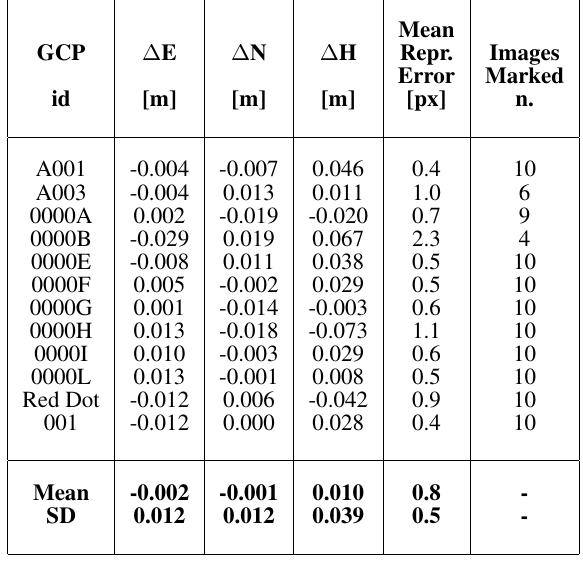
Table 4. Assessment of the standard photogrammetric pipeline - 2021 block.